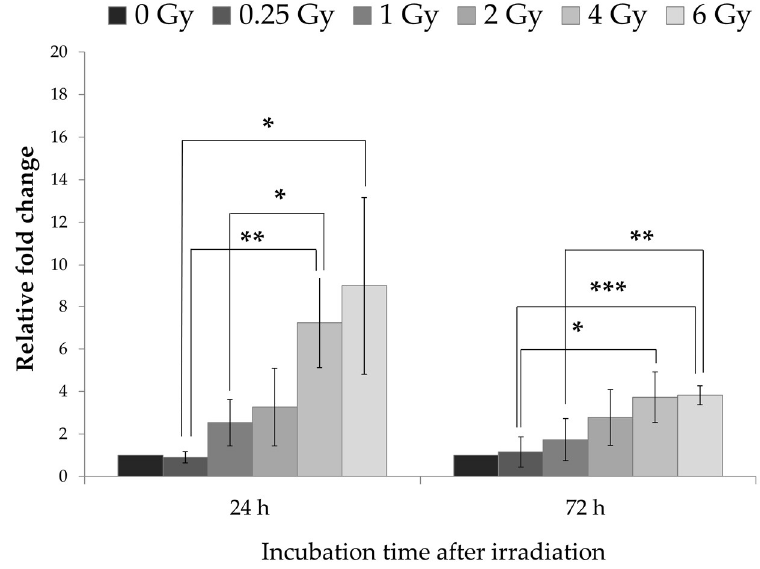
Figure 5. Influence of irradiation on gene expression of p21 in ADSC cells at different time points. Using the ΔΔC t method, data from three independent experiments were presented as mean of the relative expression values ± standard deviation. Asterisks illustrate significance: * p < 0.05; ** p < 0.01; *** p < 0.001.